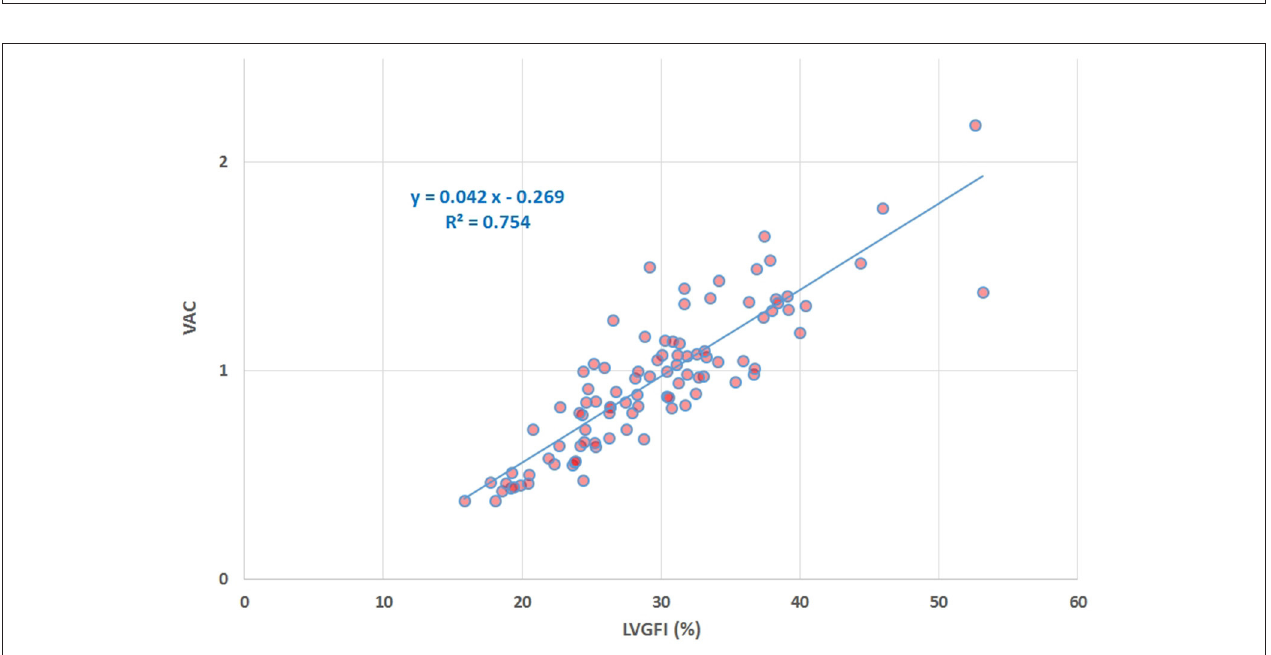
FIGURE 4 | Scatter plot of EF (%) vs. LVGFI (%), yielding R 0.86. The high correlation clearly demonstrates that the new metric LVGFI and the traditional EF are = more or less equivalent, mainly due to the fact that they share the same components in their mathematical definitions.